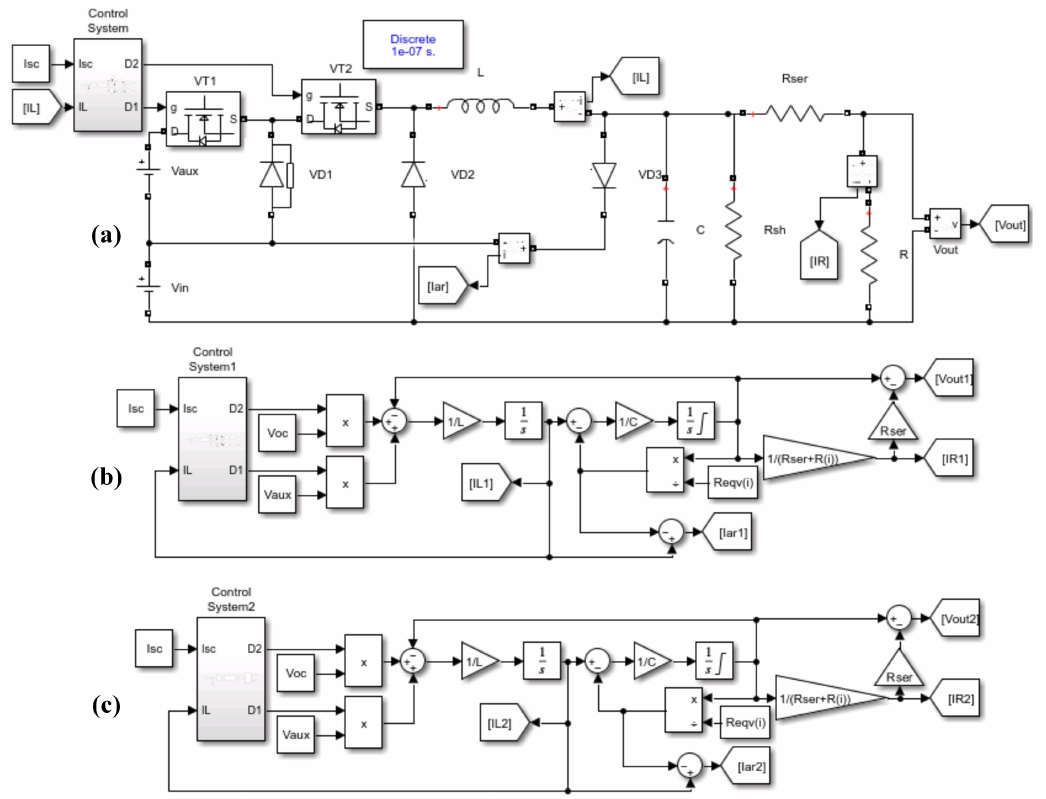
Figure 6. Simulator models: ( a ) model in Specialized Power Systems domain; ( b ) discrete block diagram model; ( c ) continuous block diagram model. 1e-07 = 1 × 10 − 7 .